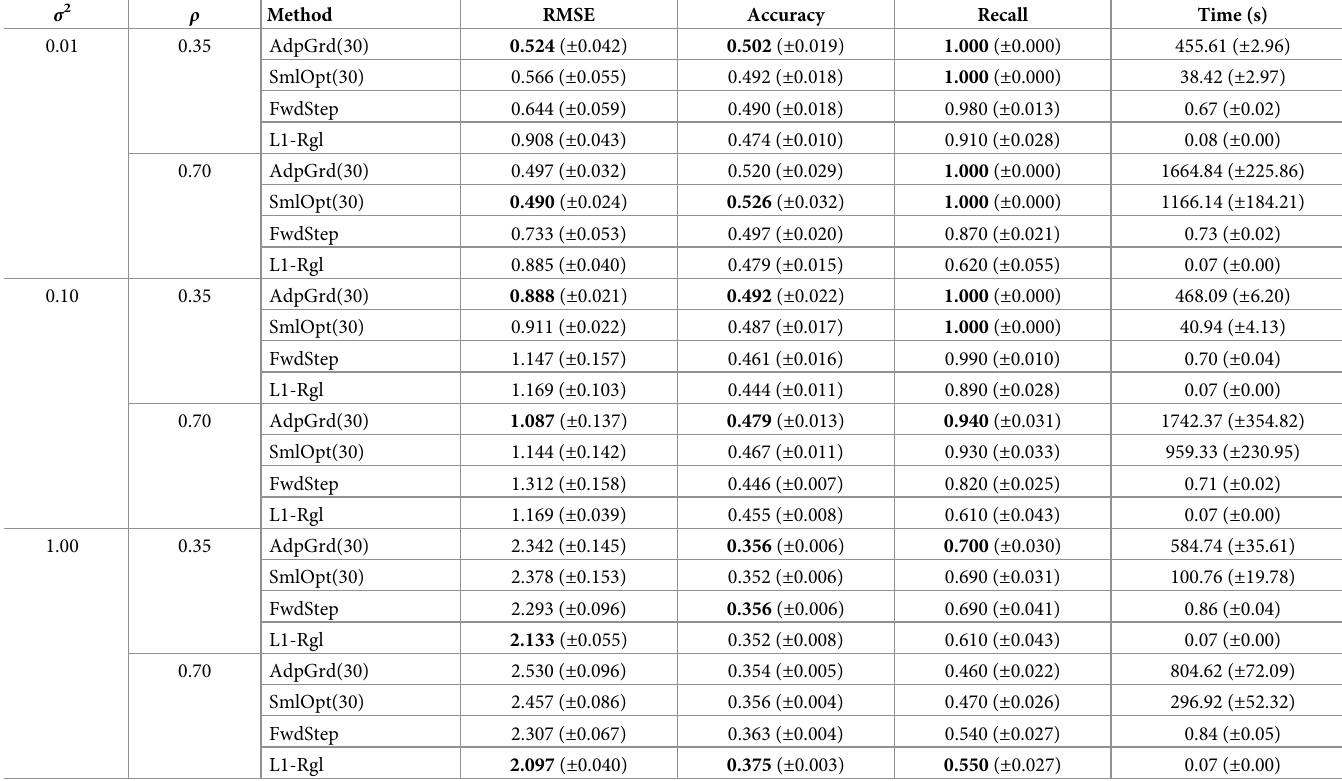
Table 4. Prediction performance for synthetic test instances ( θ = 10).